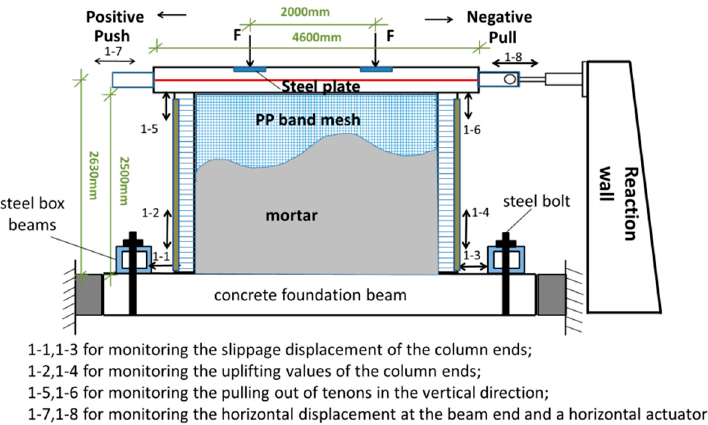
Figure 10. Test setup and measurement diagram.